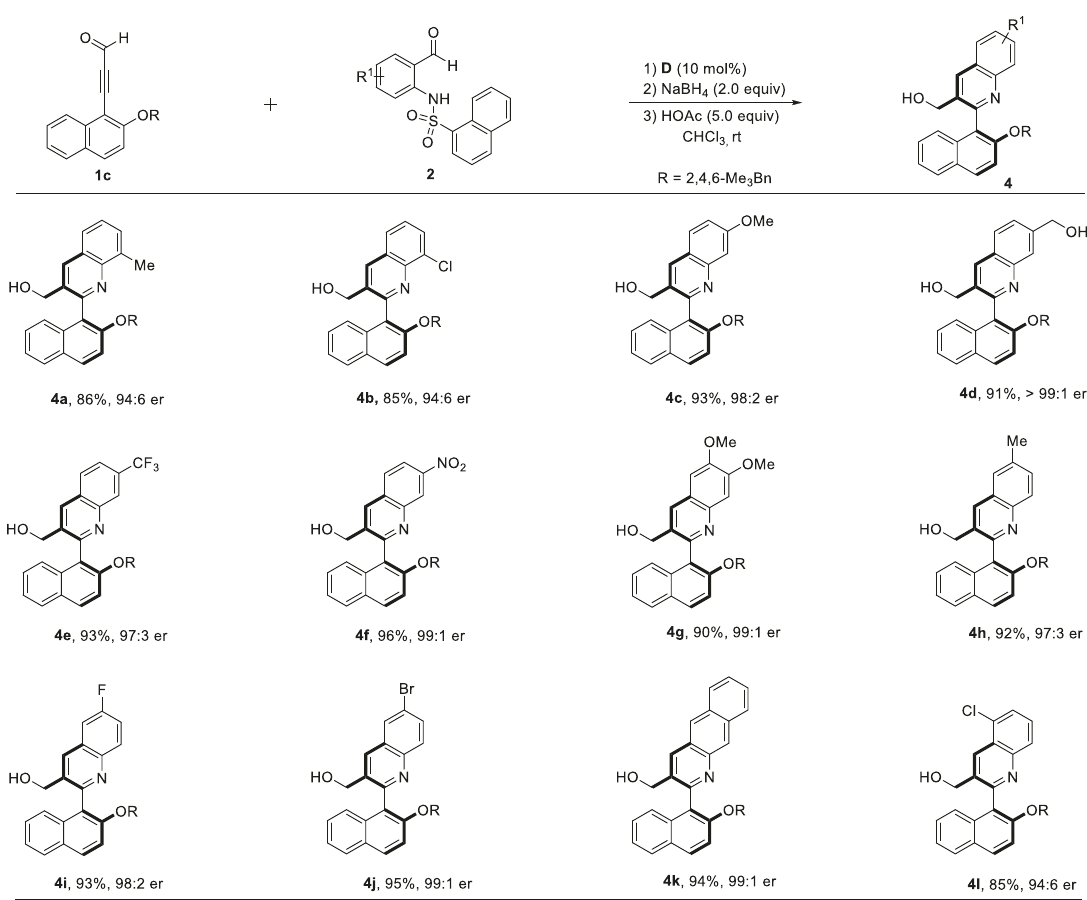
Fig. 3 Scope of N-(2-formylphenyl)naphthalene-1-sulfonamides. Reaction conditions: a mixture of 1c (0.11 mmol), 2 (0.1 mmol) and catalyst D (10 mol%) in CHCl 3 (1.0 mL) was stirred at room temperature for 24 – 36 h. After the reaction was completed, the reaction was cooled to 0°C, then MeOH (0.5 mL) and NaBH 4 (0.2 mmol) were added to the mixture and stirred for another 0.5 h at room temperature. At last, HOAc (5.0 equiv) was added to the mixture and stirred for another 2